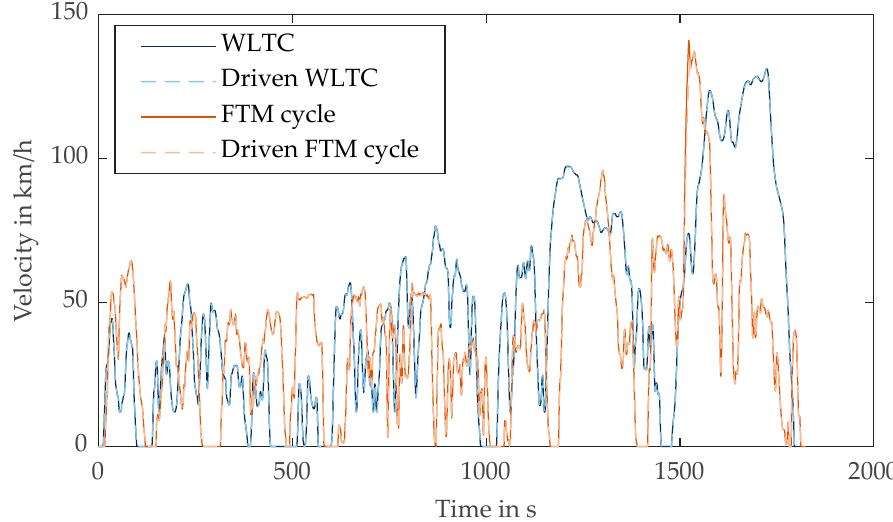
Figure 3. Velocity of the predetermined driving cycles and the actual driven vehicle velocity. WLTC: Worldwide harmonized Light vehicle Test Cycle.